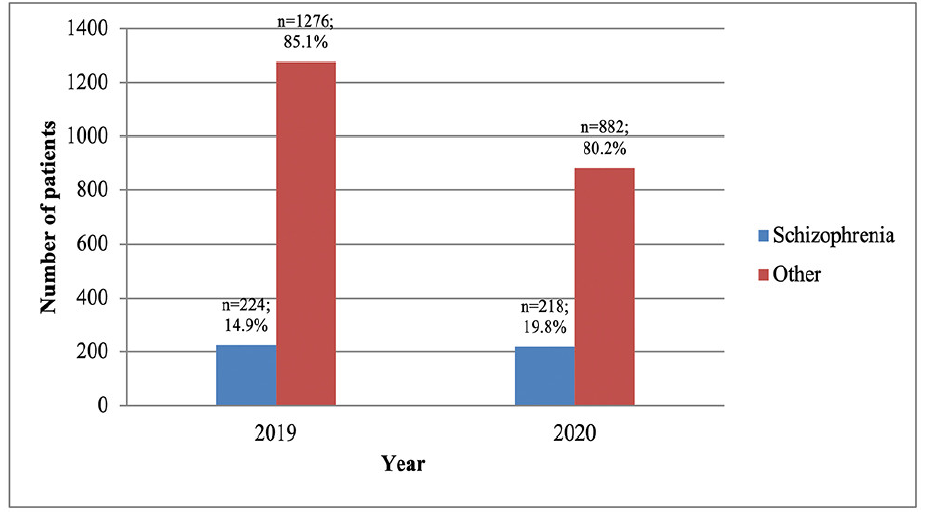
Figure 2. The total number of hospitalization and the number of cases with